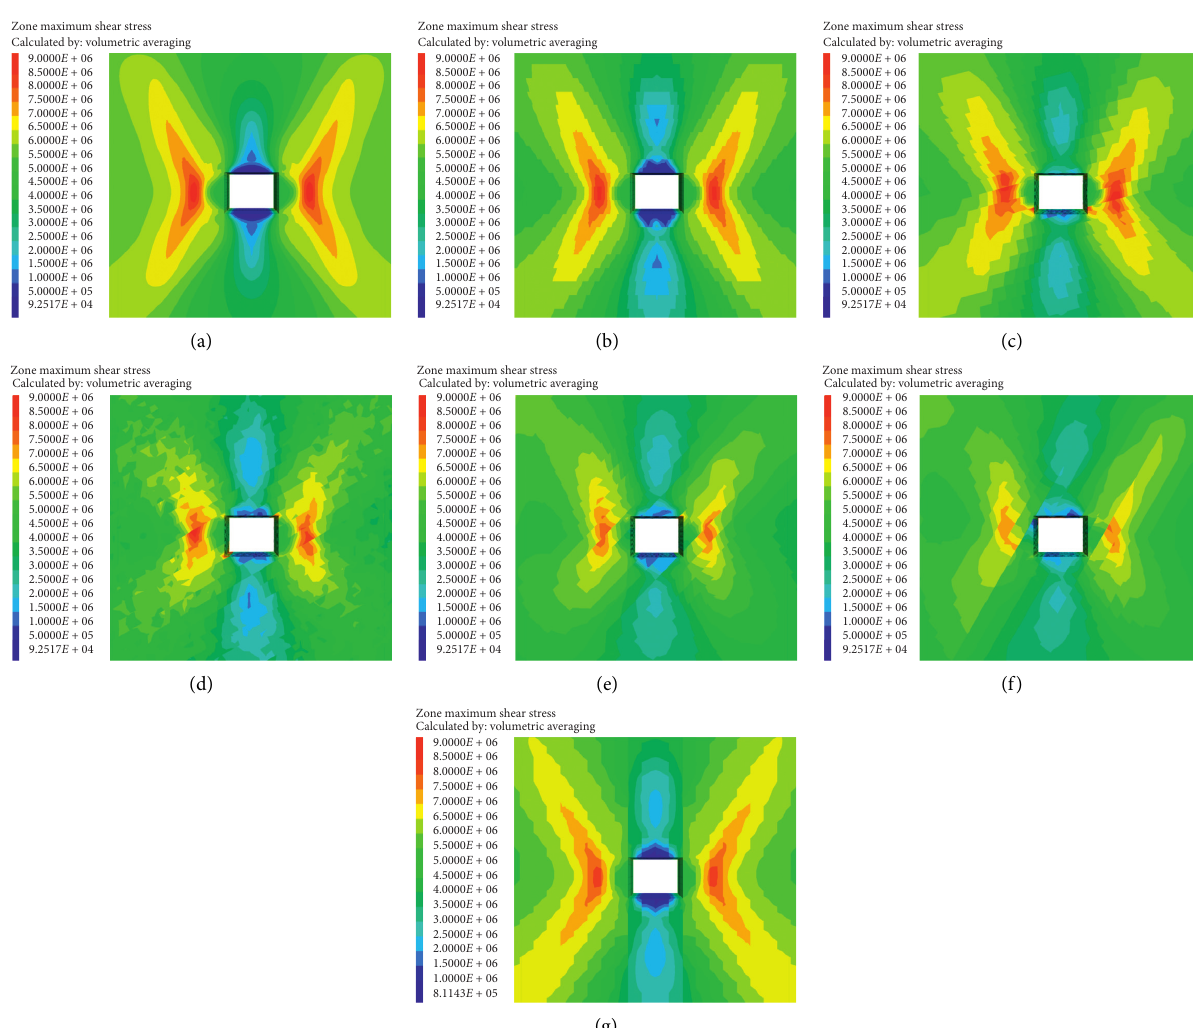
Figure 4: Distribution cloud diagram of maximum shear stress. (a) No structural plane. (b) 0 ° . (c) 15 ° . (d) 30 ° . (e) 45 ° . (f) 60 ° . (g) 90 °